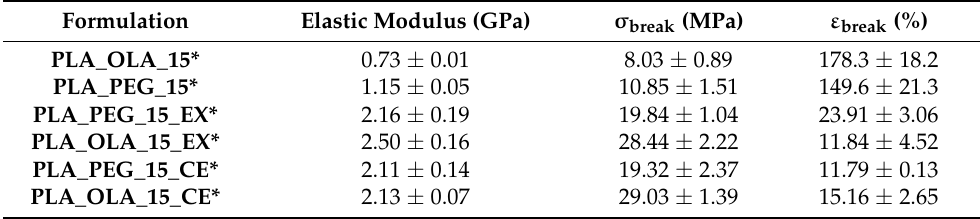
Table 3. Tensile properties of the up-scaled film